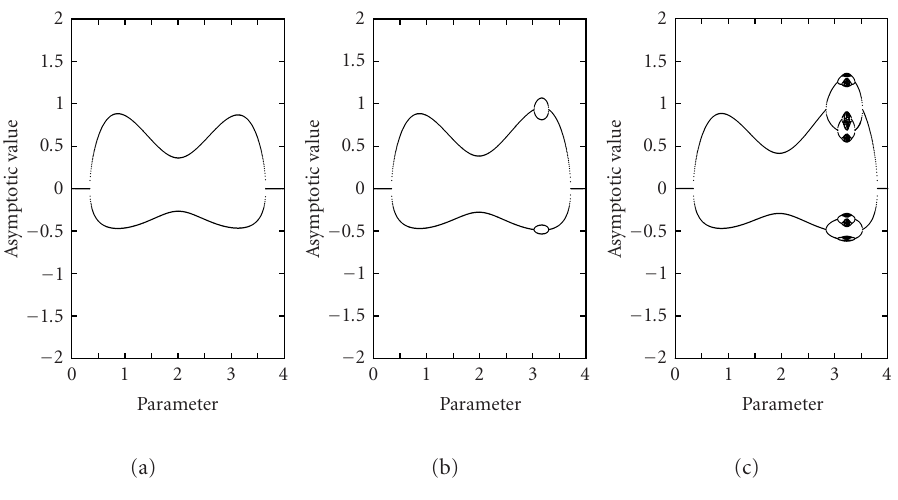
Figure 4.2. Regular reversal maps for (a) α = 0 . 19166, (b) α = 0 . 191, and (c) α = 0 .